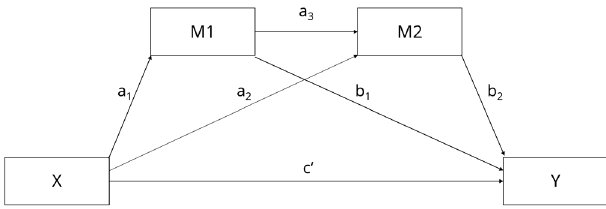
FIG. 2. Visual representation of Eqs. (5) to (7) showing serial mediation with two